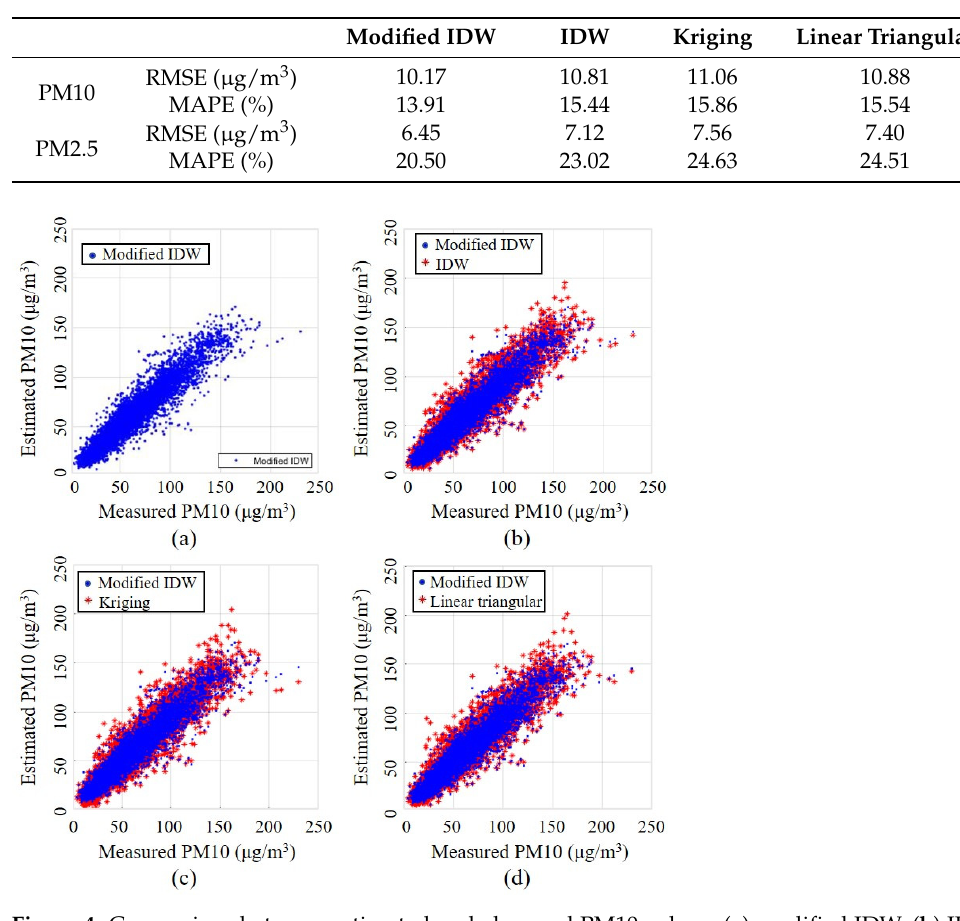
Table 2. PM interpolation errors for different algorithms.